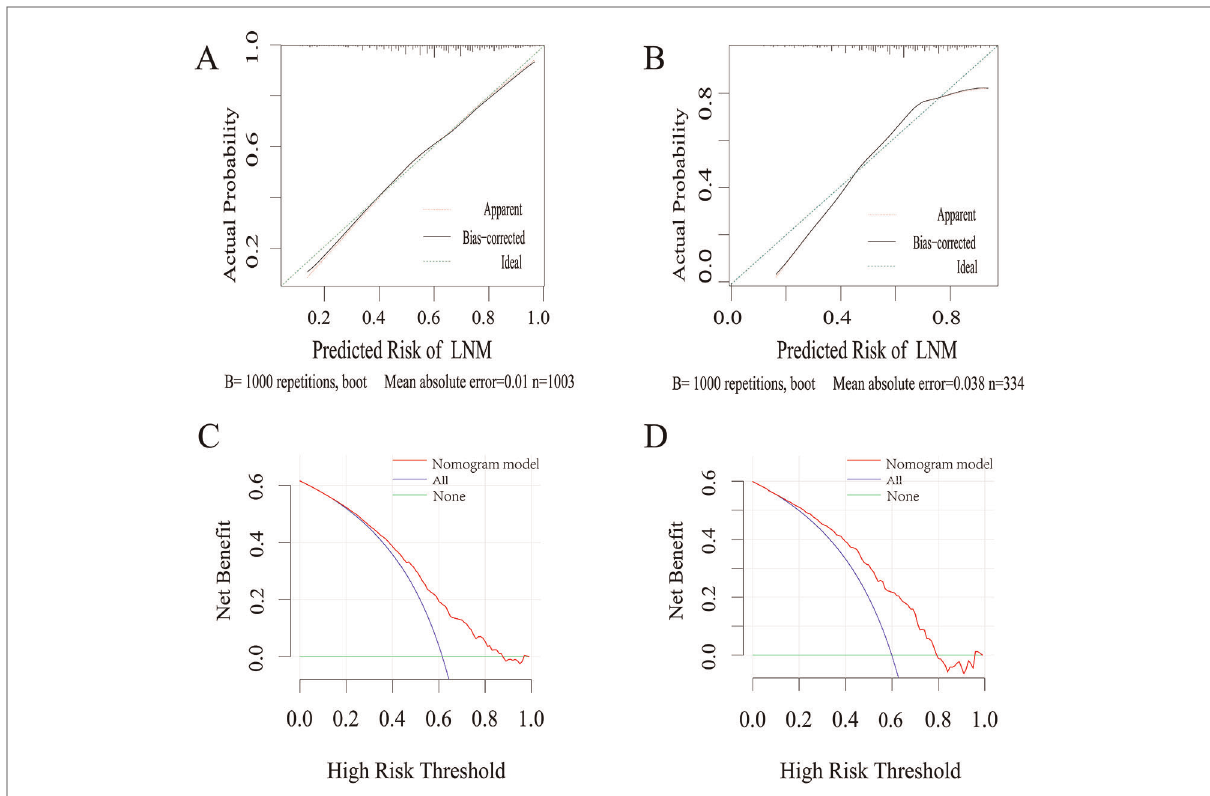
FIGURE 4 ( A,B ) Calibration curves of the developed nomogram in training and validation cohort. The x -axis represents the predicted probability from the nomogram, and the y -axis is the actual probability of LNM in GC patients. ( C,D ) DCA of the risk assessment model in the training and validation cohort. The y -axis measures the net bene fi t. The red line represents the predicted nomogram model. The blue line represents the assumption that all GC patients had LMN. The green line represents the assumption that no patients had LMN. The net bene fi t was calculated by subtracting the proportion of all patients who are false positive from the proportion who are truly positive. LNM, lymph node